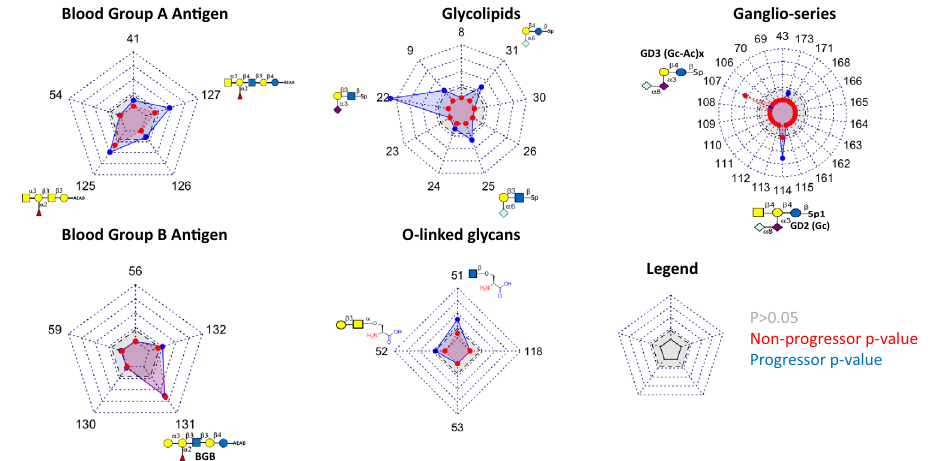
Fig. 3 | ACAs differently detected in non-progressors and progressors com- paredtocontrols. Radar charts showing – log10( p value) with blue representing association with progression and red representing association with non- progressors. The gray shadowed area represents non-signi fi cances ( p >0.05). Shaded area in red shows signi fi cant associations with non-progressors status